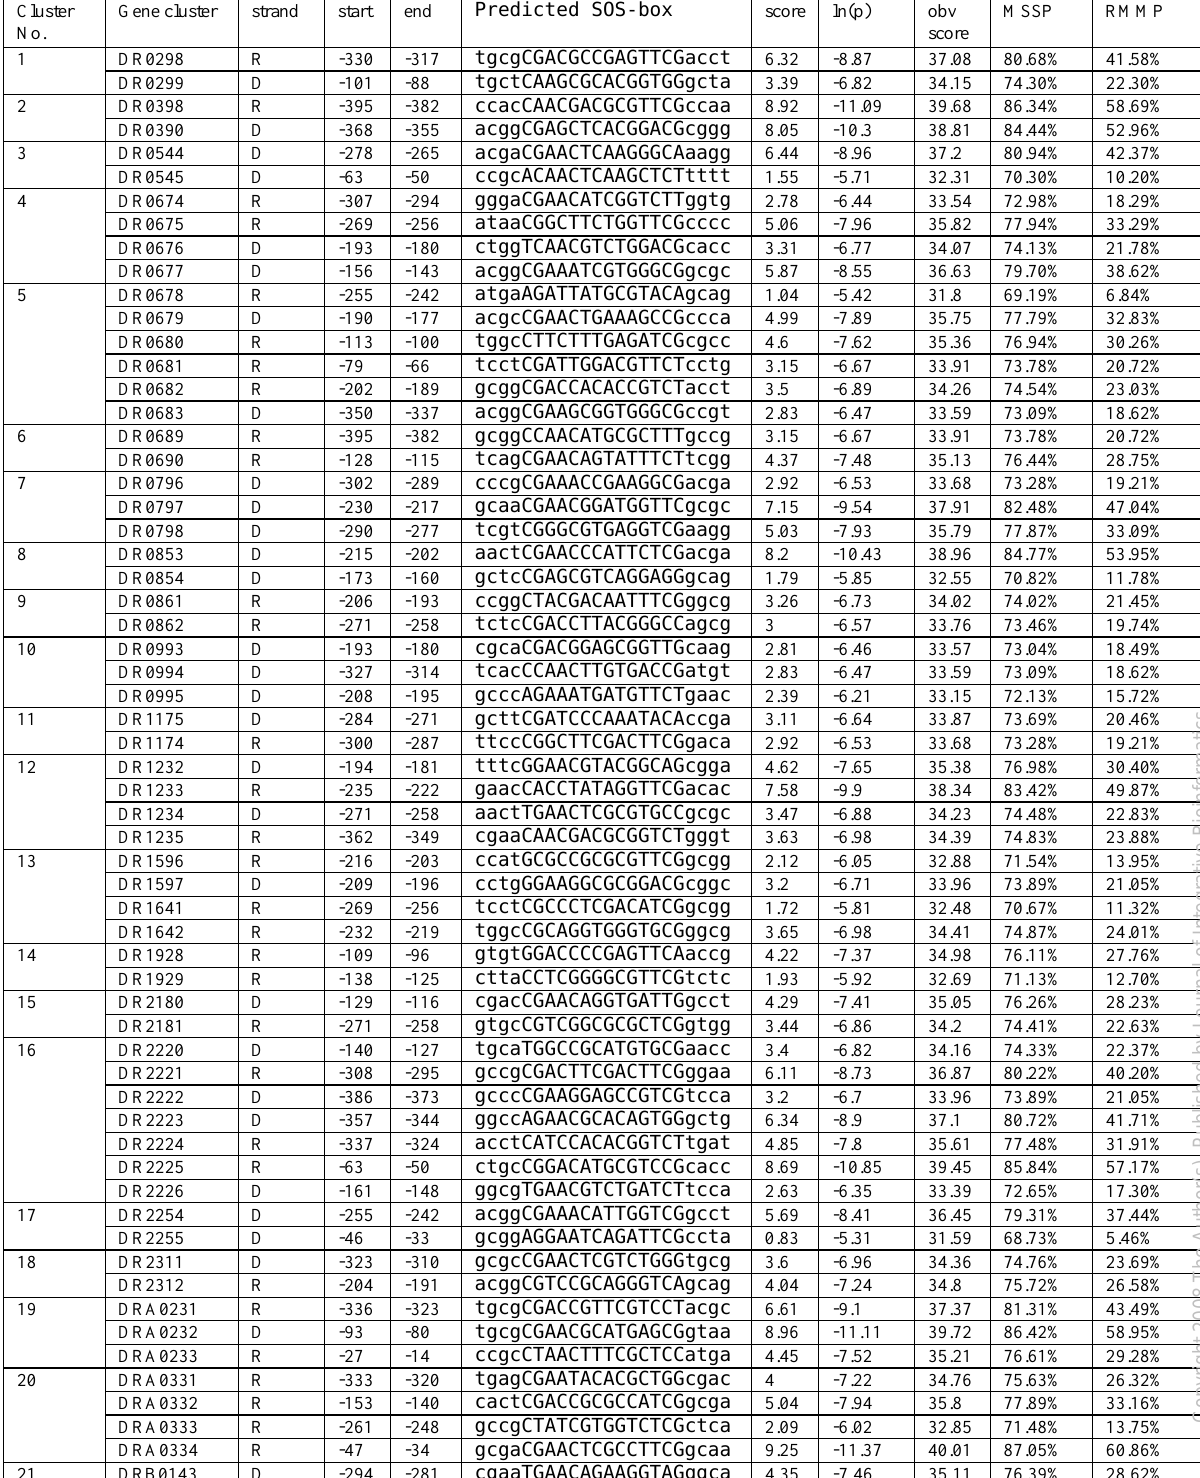
Supplementary Table 11 (S11): Details of SOS-box motifs predicted in the upstream sequences of D. radiodurans genes related to some unusual predicted operons through RSAT webserver. Cluster